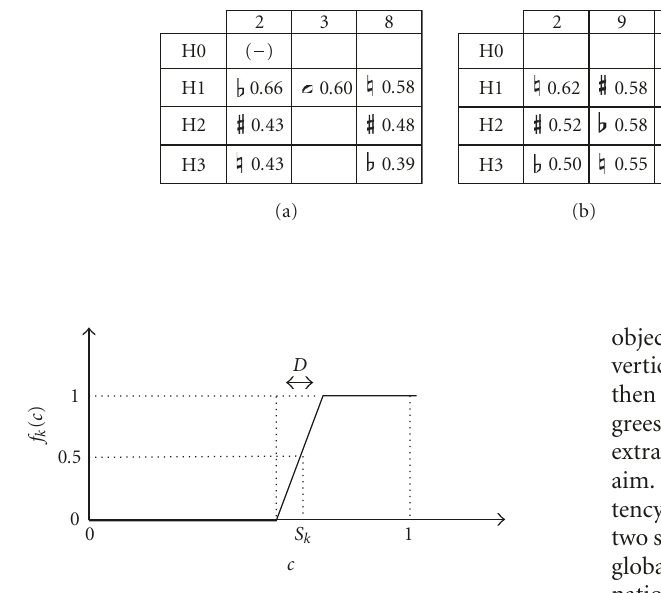
Figure 13: Possibility distribution of class k